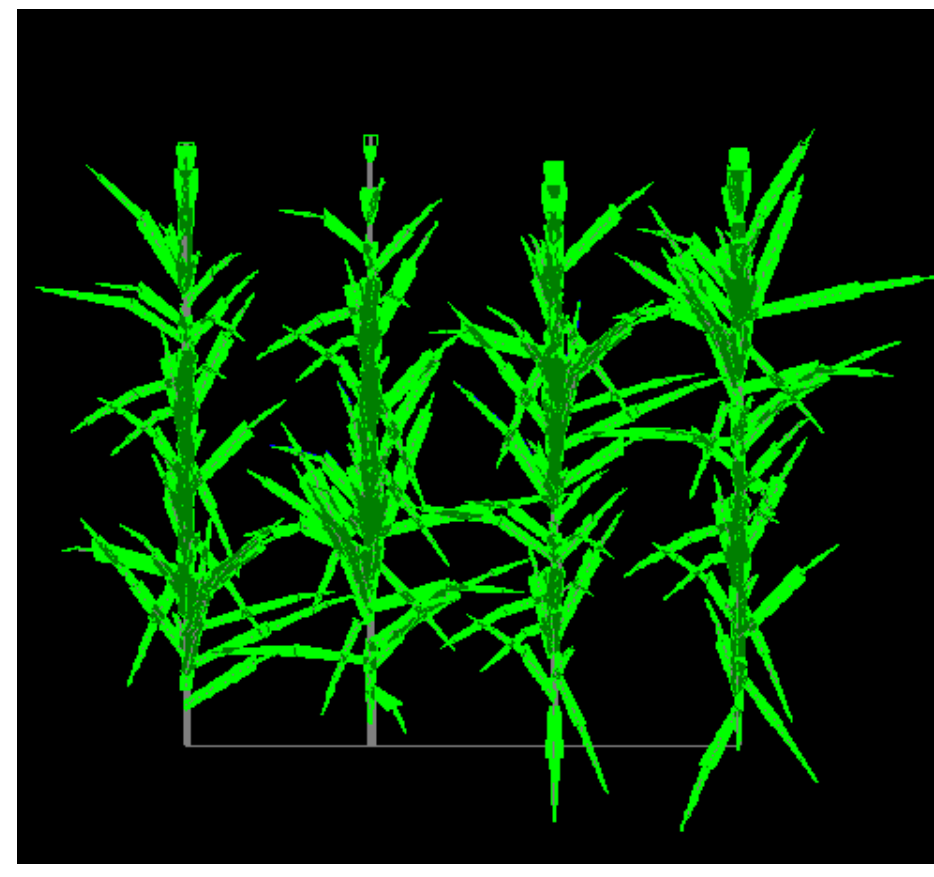
FIGURE 1. Wheat 3-D aerial architecture model plot using the YPLANT